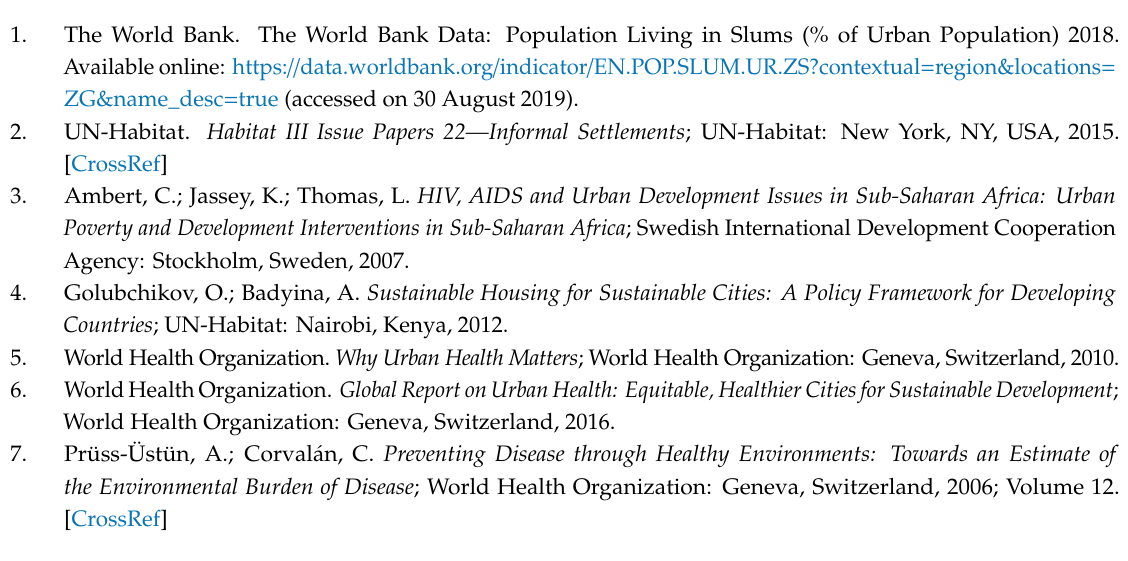
Table S1: Search strategy undertaken for initial 2017 search, Table S2: Search strategy undertaken for additional search conducted in